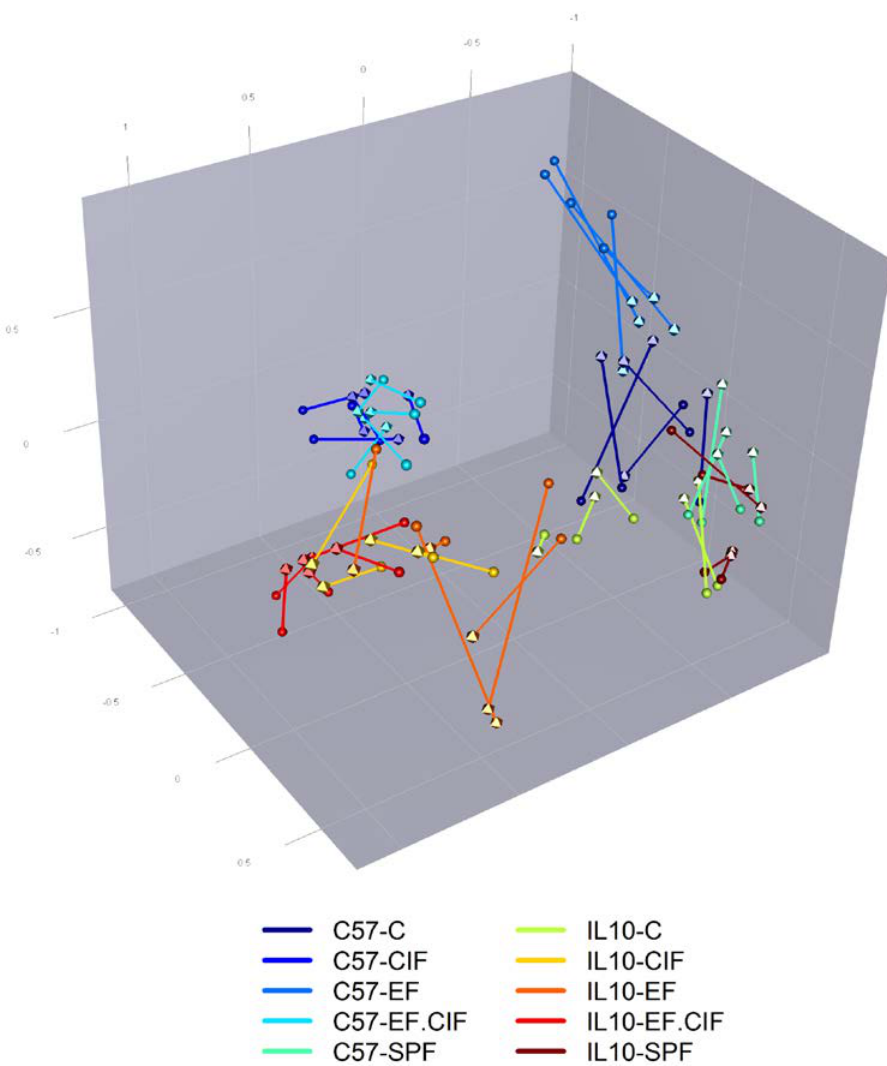
Figure 3. Procrustes rotation analysis comparing Unifrac phylogenetic distances from pyrotag sequencing and DGGE profiles of caecal communities of C57 and Il10 -/- mice in treatment groups SPF, C, EF, CIF and EF-CIF. Procrustes analysis is a method for